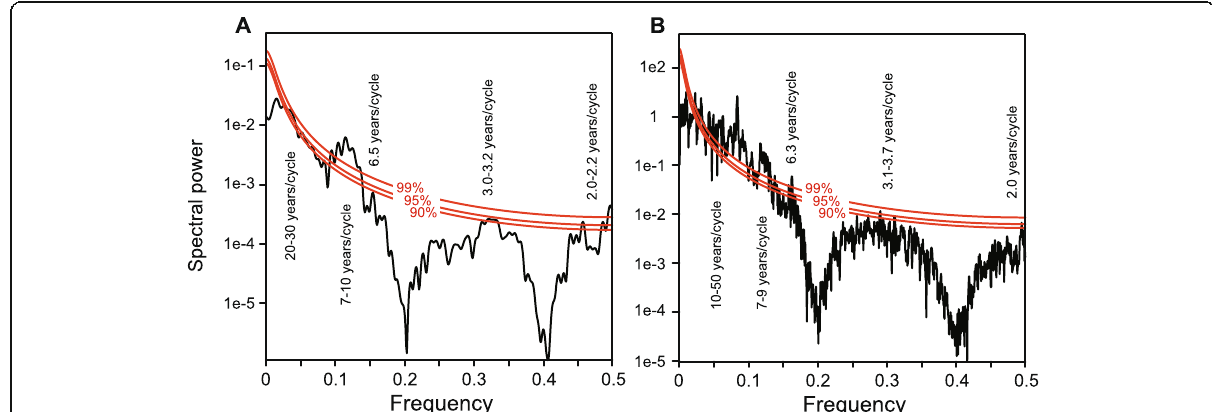
Fig. 8 Results of multi-taper method spectral analyses of the SMJ-2-S1 sclerosponge δ 18 O ( A ) and instrumental SST (ERSST v3b) ( B ) for 1880 – 2012. The 90%, 95%, and 99% confidence levels are shown as red lines. Numbers denote interannual to decadal periodicity with significant peaks at the confidence level